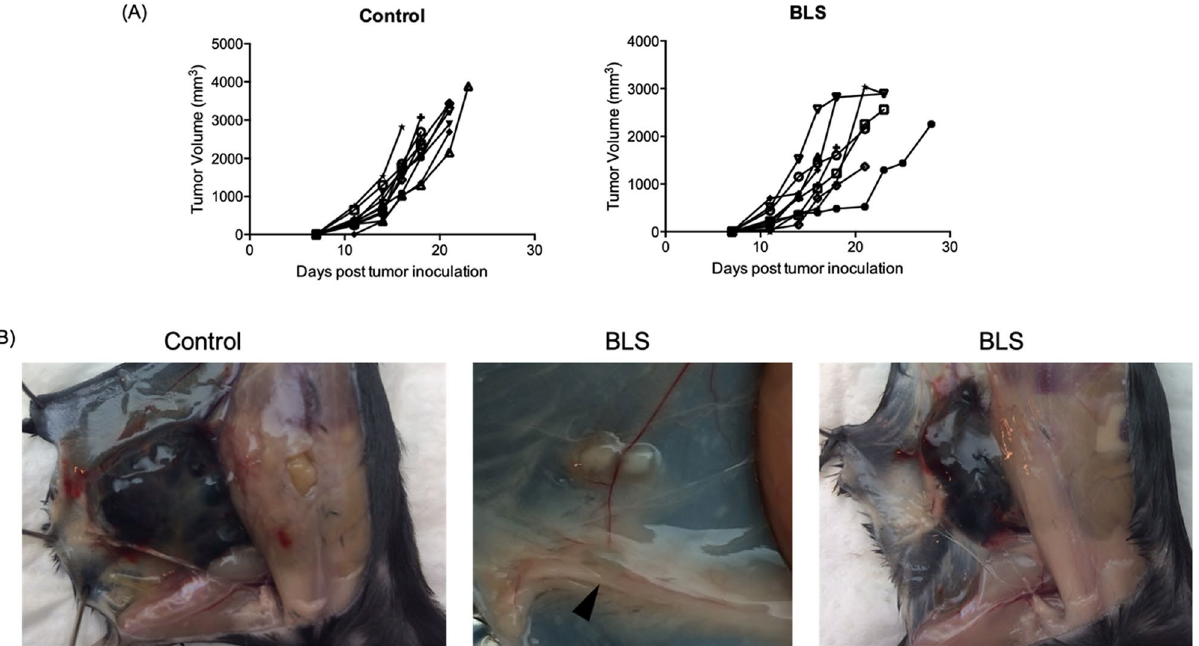
Figure 1. BLS treatment delays tumor growth. C57BL/6J mice were inoculated with 1.25 × 10 5 B16 cells subcutaneously in the right flank. At day 2, 200 μg of BLS or PBS (control) were subcutaneously administered in the base of the tail. Tumor growth ( A ) was followed every 2–3 days and tumor volume was estimated as 0.5 × (length × width 2 ). Data pooled from two independent experiments (n = 4 or 5 mice per group per experiment). Representative photos of a control tumor and a photo the smallest and biggest tumors from BLS treated mice at day 14 after tumor inoculation are shown ( B ). The arrow shows the tumor draining lymph